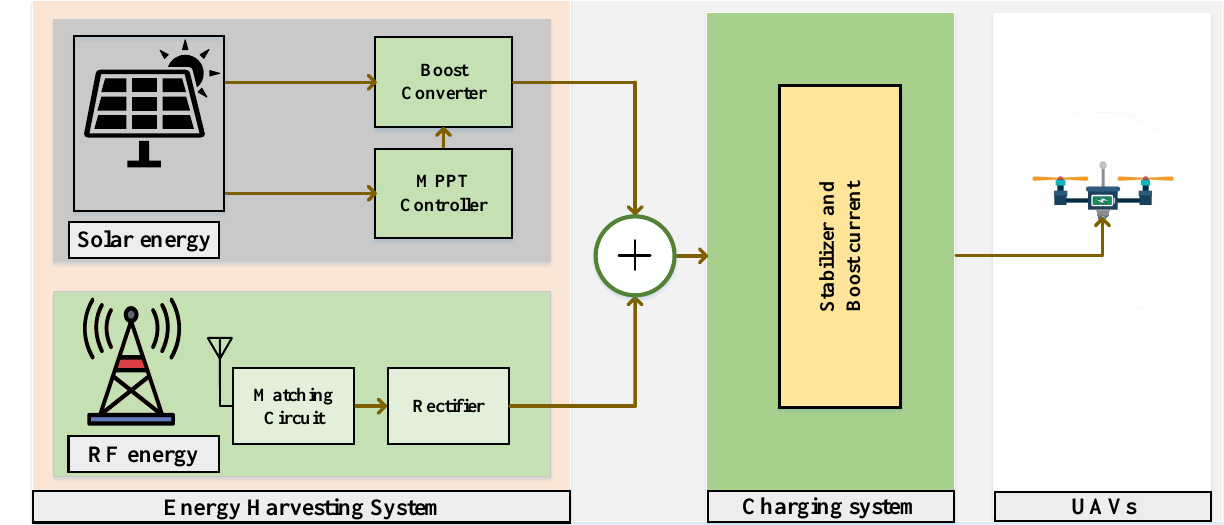
Figure 1. The block diagram of model system for